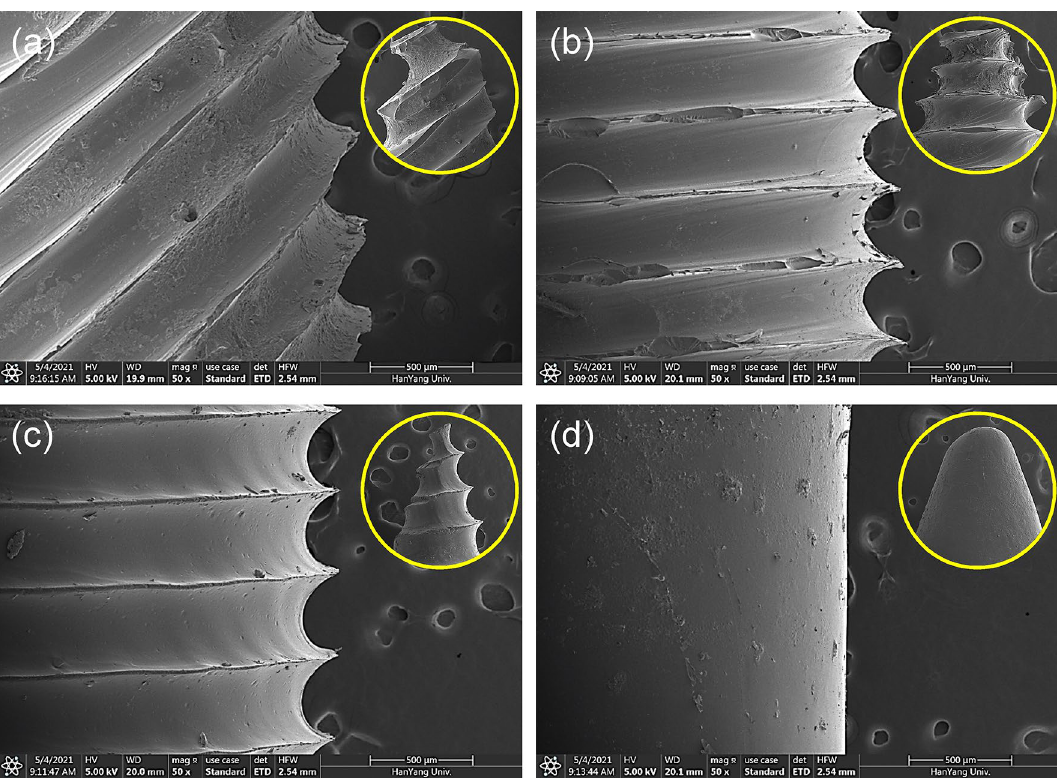
Figure 6. SEM images of fabricated MDDs with ( a ) 45°-tilted blades, ( b ) 0° blades, ( c ) helical blades, and ( d ) no blades (i.e., plain type). Inset: tip of each MDD.